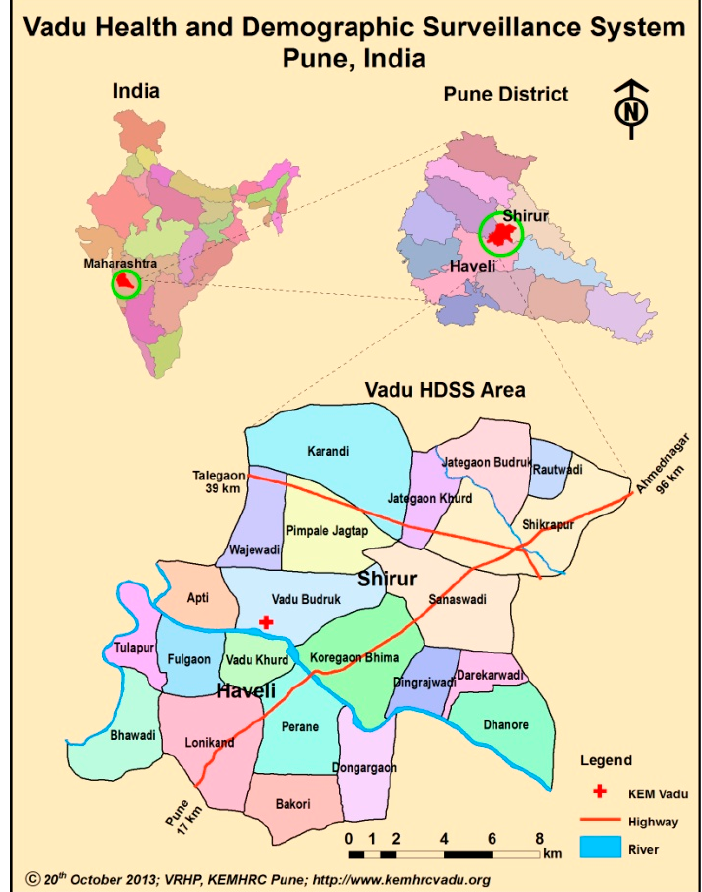
Figure 1. Map of Vadu HDSS area (22 villages of Pune district) located in Western India.